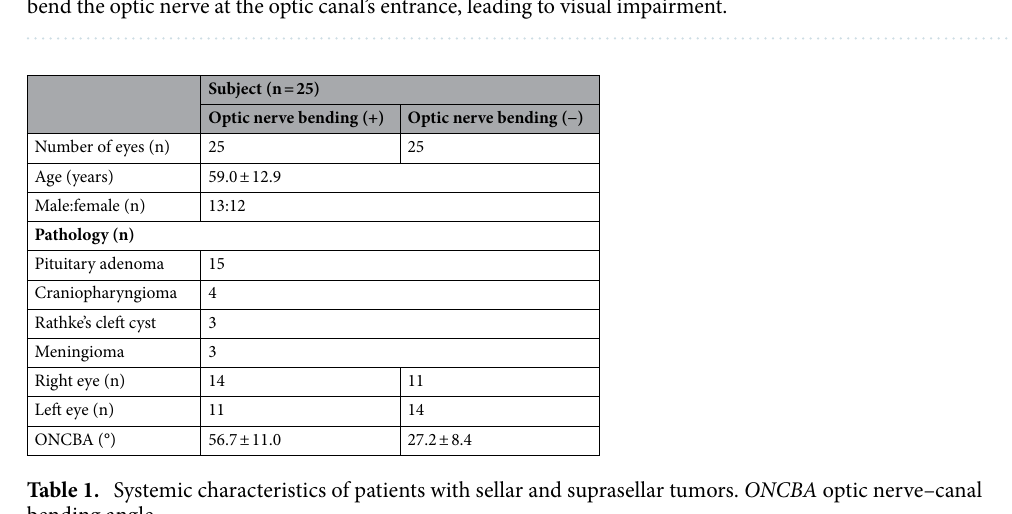
Figure 1. Schema from the eyeball to the optic chiasm in a patient with sellar and suprasellar tumor. The gray polygon in the left panel showed a cross-section of the path from the eyeball to the optic chiasm, as shown in the right panel. The upper right panel showed a schema of optic chiasm compression by the suprasellar and suprasellar tumor. The lower right panel showed a schema of optic nerve bending by the suprasellar and suprasellar tumor. The enlarged sellar and suprasellar tumor causes visual field defects due to optic chiasm compression. However, sellar and suprasellar tumors, with or without optic chiasm compression, sometimes bend the optic nerve at the optic canal’s entrance, leading to visual impairment.